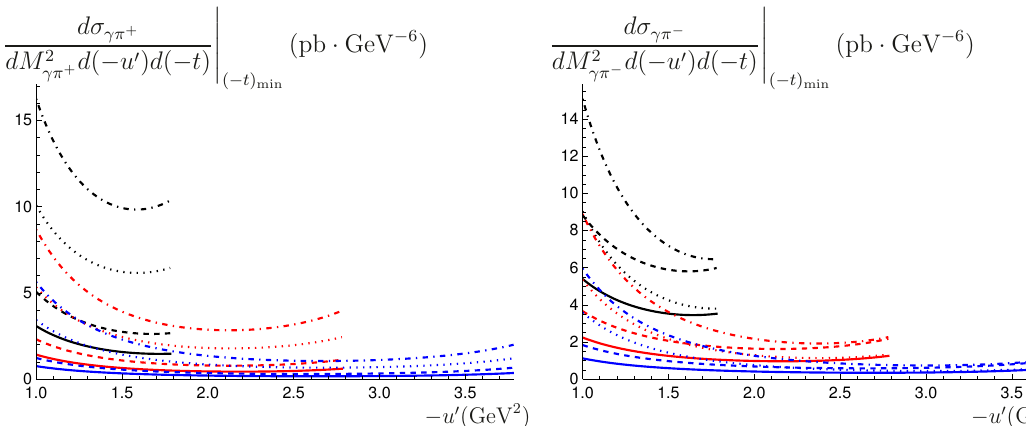
Figure 33 . The fully differential cross-section for π + ( π − ) is shown as a function of ( − u 0 ) on the left (right) for different values of M 2 . The black, red and blue curves correspond to M 2 γπ respectively. The dashed (non-dashed) lines correspond to holographic (asymptotic) DA, while the dotted (non-dotted) lines correspond to the standard (valence) scenario. S